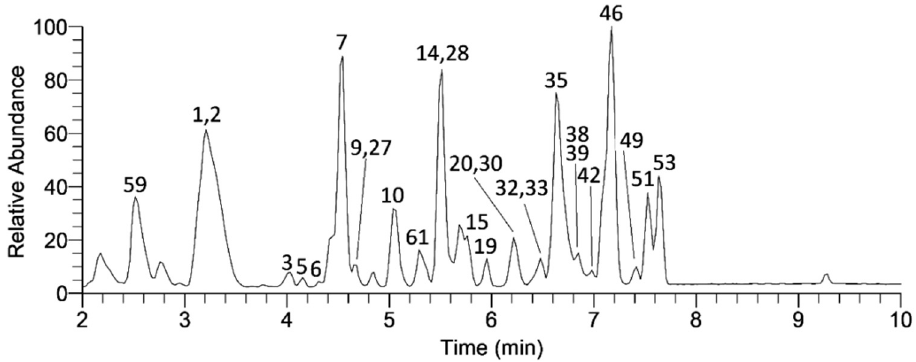
Figure 1. Base peak chromatogram of the leaf sample from Mali Lošinj Island. The peak numbers correspond to Table 1.